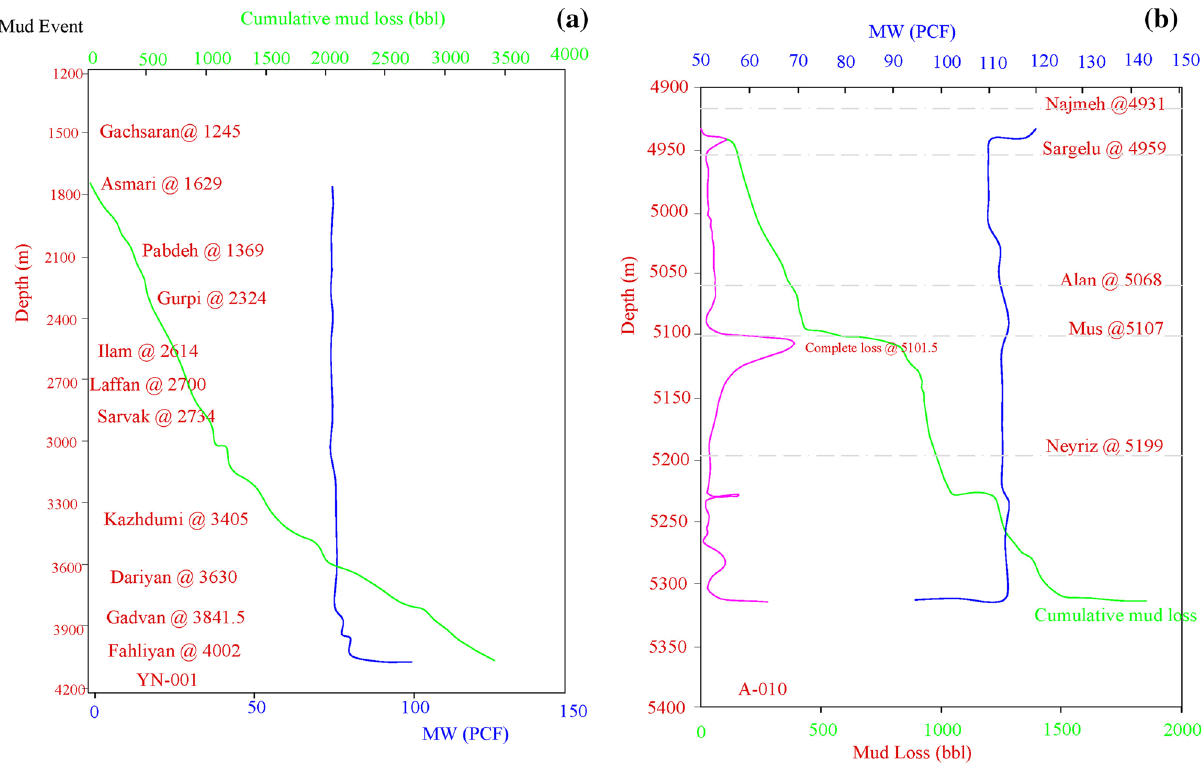
Fig. 14 Changes in mud weight (PCF) and accumulated mud loss of a YRN-001 exploratory well and b exploratory well of A-010 in the Juras- sic deep formations below Gotnia (Mohammadi and Farhani